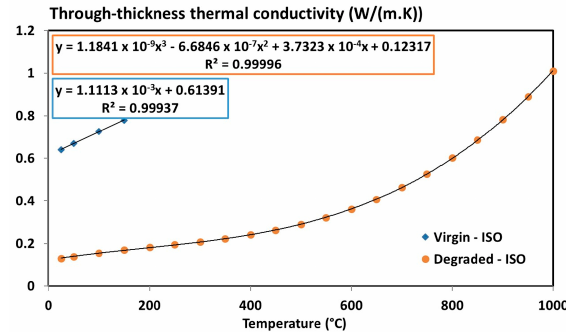
Figure 8. Through-thickness thermal conductivity of the T700/M21 composite (virgin and degraded state) as a function of the temperature [6].